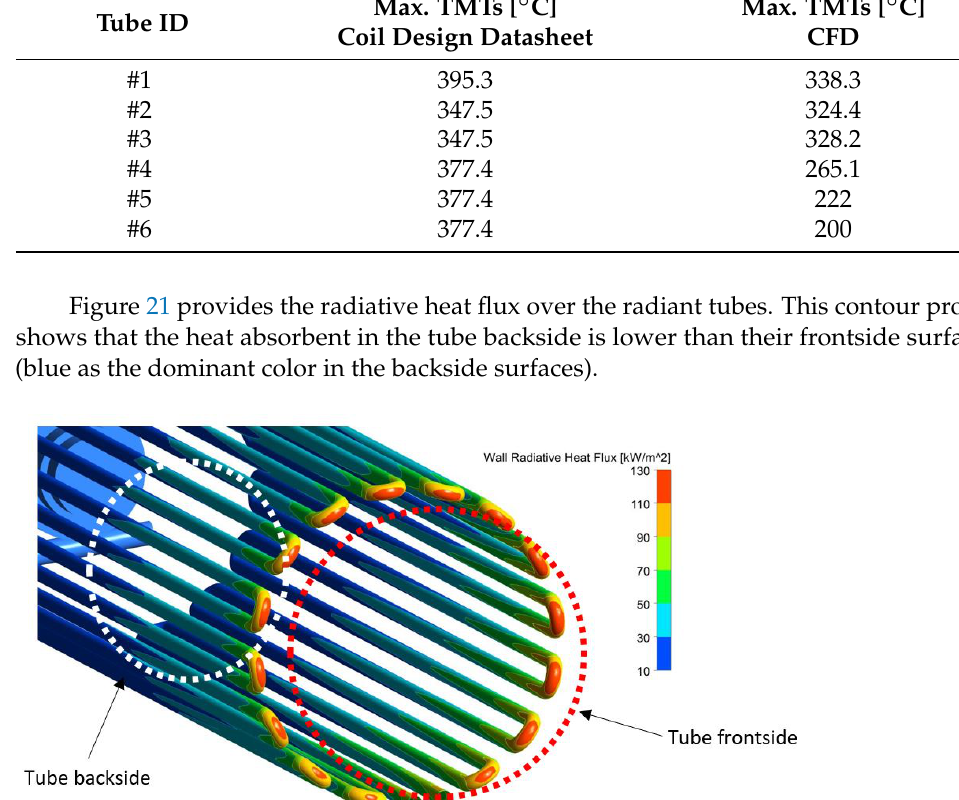
Figure 21. Wall radiative heat flux over the radiant